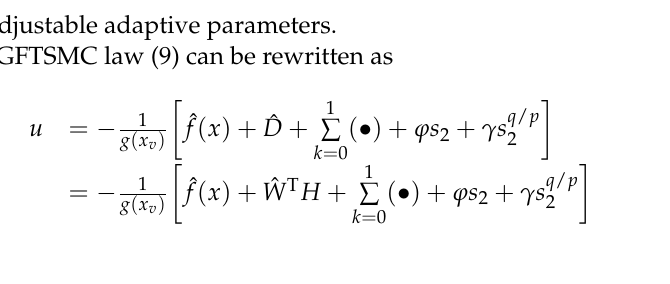
is the state vector of the system.